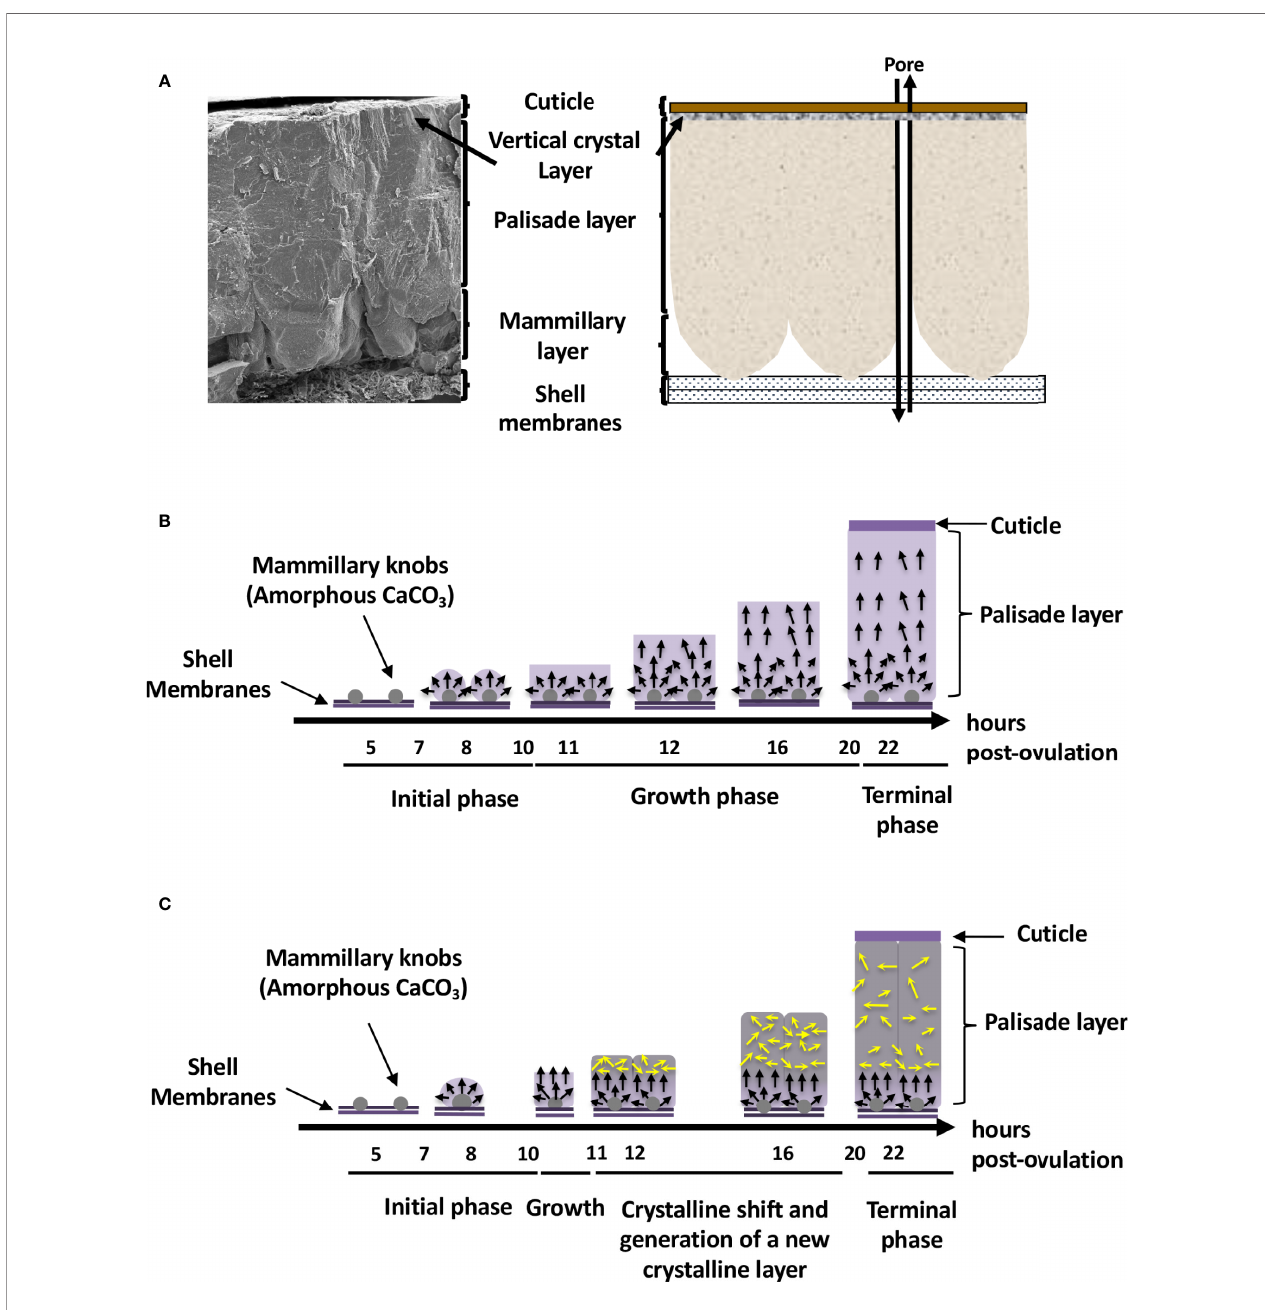
FIGURE 1 | Avian eggshell structure and kinetics of its mineralization events. (A) Scanning electron microscope photography (left) and diagram (right) showing the six different layers composing the avian eggshell. From inside to outside are the two proteinaceous eggshell membrane layers supporting the calci fi ed region of the shell (mammillary, palisade and vertical crystal layers). The most external zone is the thin organic cuticle layer. (B) Scheme representing shell mineralization pivotal stages that determine the eggshell ultrastructure and crystallographic texture in most bird species. They correspond to the initial stage dominated by amorphous calcium carbonate (ACC) deposition on eggshell membranes, its progressive transformation to form calcite aggregates on mammillary knobs, and the growth of large calcite units. The last stages correspond to the formation of the columnar calcite crystals and the deposition of cuticle. Black arrows describe the orientation of crystals that compete for the available space and only those favorably oriented nearly perpendicular to the shell surface (along the c-axis), are selected and contribute to the development of a preferential orientation of crystals. Timing (hours post-ovulation) are given for the kinetics of chicken eggshell fabrication. (C) Speci fi c bilayer structure of the Guinea fowl eggshell. Guinea fowl eggshell mineralization initially follows the same pattern described in chicken resulting in the characteristic columnar structure (black arrows). However, a sharp change in the size and orientation of crystals occurs (yellow arrows) at 11 hours post ovulation, when one-third of the fi nal eggshell thickness has been deposited. At this point, the large columnar calcite units break up into smaller crystal units with varying crystallographic orientations forming a microstructure with an intricate interlacing of calcite crystals, leading to the formation of a secondary layer with misoriented